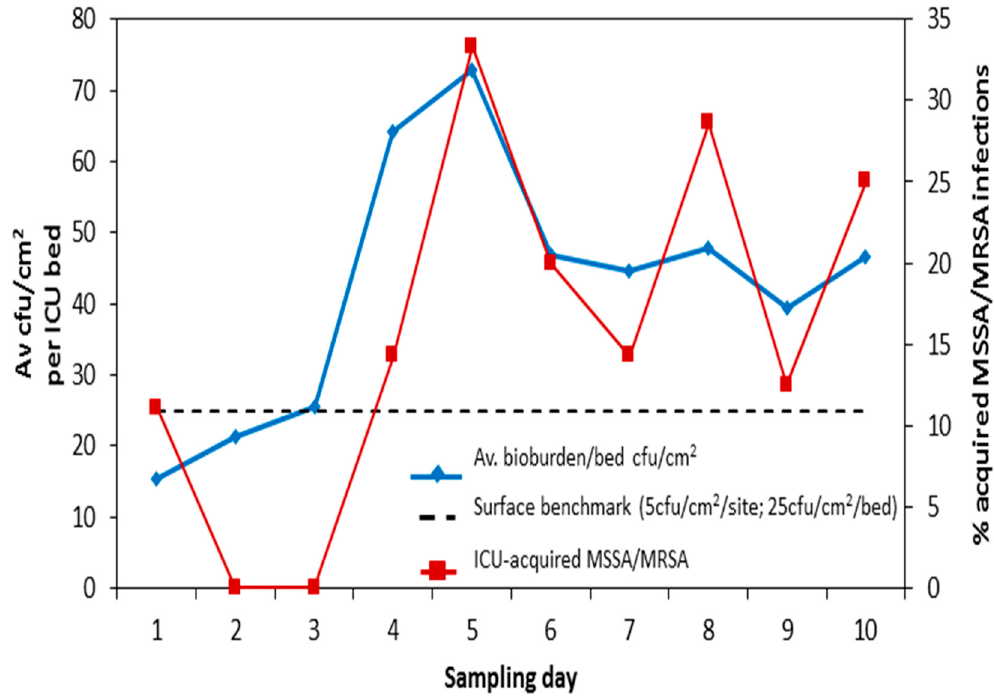
Figure 4. Is surface bioburden associated with clinical risk? Total bioburden (5 sites)/bed (cfu/cm 2 ) plotted against % ICU-acquired S. aureus infection (adjusted for bed occupancy) for Beds 2–10 on 10 sampling days. ICU: intensive care unit; MSSA: methicillin-susceptible S. aureus ; MRSA: methicillin- resistant S. aureus.